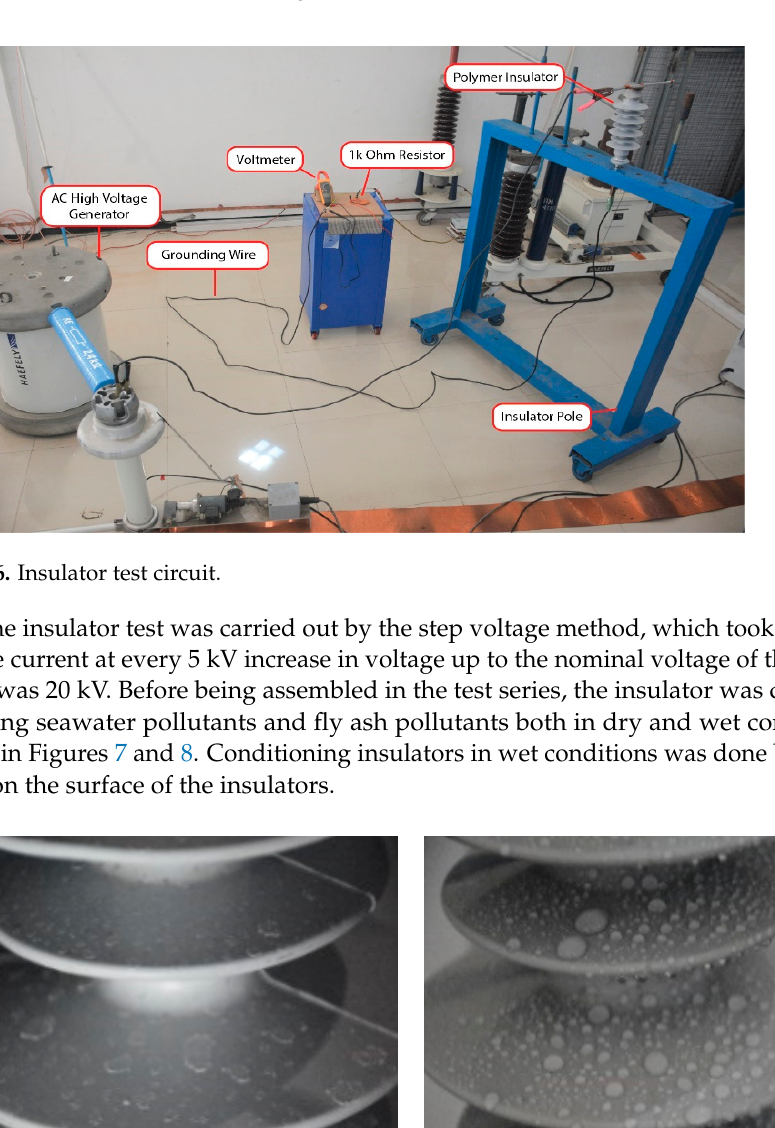
( b ) Figure 8. Insulators given fly ash pollutant in ( a ) dry and ( b ) wet conditions. 4. Result and Data Analysis This section discusses the analysis based on the results of simulations and tests that were carried out. Simulation analysis consisted of the effect of salt and fly ash contaminants on voltage distribution, electric field distribution, current density, and leakage current, while the analysis consisted of a comparison of the leakage current insulator without aging and aging, the effect of voltage changes on the leakage current insulator and the effect of ESDD on the leakage current insulator, and the effect of NSDD on the leakage current insulator. The analysis in the test was divided into two parts, namely dry conditions and wet conditions. Furthermore, a comparison was made between the simulation results and the leakage current. 4.1. Polymer Insulator Simulation Results Insulator material parameters must be filled in first. The simulation of electric field distribution and voltage distribution uses the Electrostatics physics module, while the current density simulation uses the Electric Current physics module. The module is already installed on COMSOL Multiphysics. 4.1.1. Voltage Distribution in Polymer Insulators The voltage applied in this simulation was 20 kV according to the voltage of the polymer insulator system used. A terminal voltage of 20 kV was applied to the conductor cable, as shown in Figure 9, and ground was applied to the bottom fitting of the insulator,